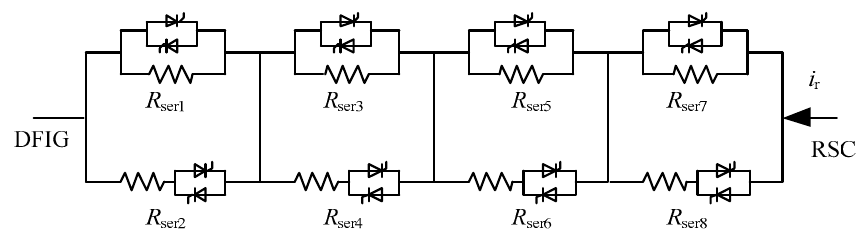
Figure 6. Rotor braking resistor array.